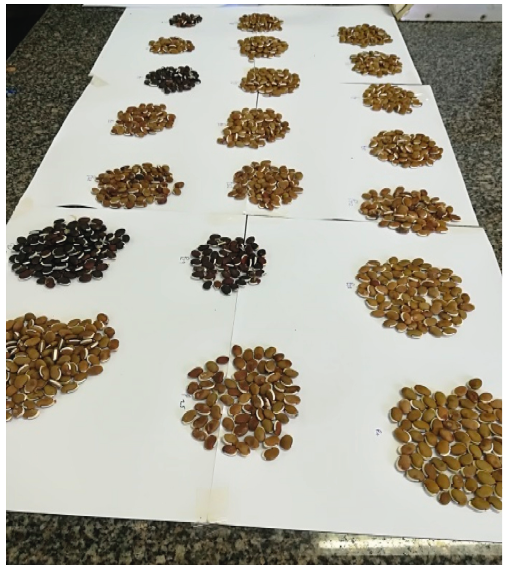
Figure 4: Lablab grain photograph during data collection.